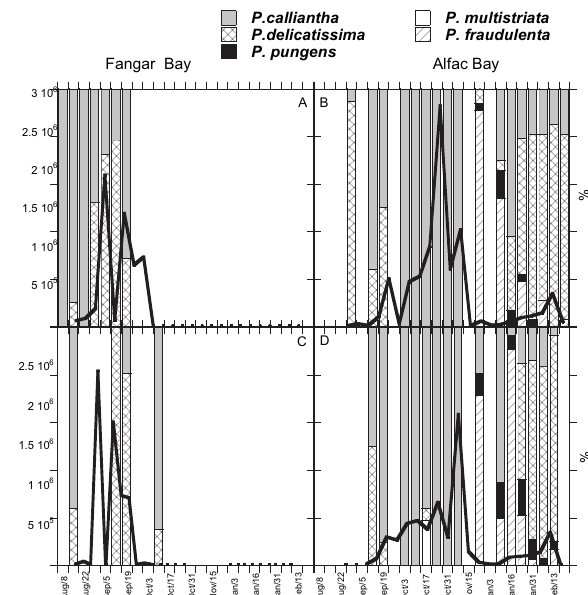
Fig . 6. – Weekly Pseudo-nitzschia cell abundance (cells l -1 ) and percentage of each Pseudo-nitzschia species (%) in Fangar Bay at the surface a) and bottom c), and in alfacs Bay at the surface B) and bottom Fig . 5. – Weekly biological and chemical parameters in Fangar Bay at the surface (a) and bottom (B) as measured at a central station. chlorophyll a concentration (µg l –1 ) and dissolved inorganic nitro- gen (din, µM) are shown on one axis. dissolved inorganic p and Si (µM) on the other. probable inorganic p limitations is indicated in the graph as •.